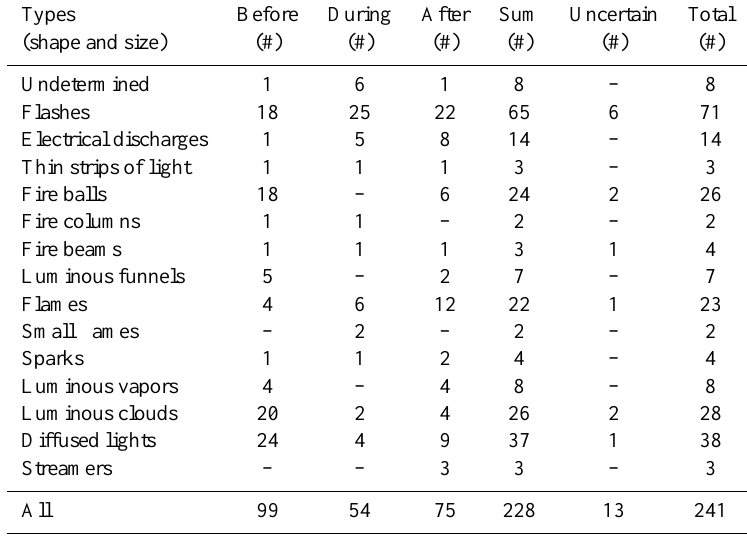
Table 3. The Aquila collection was ordered in accordance with the Galli classification. Types Before During